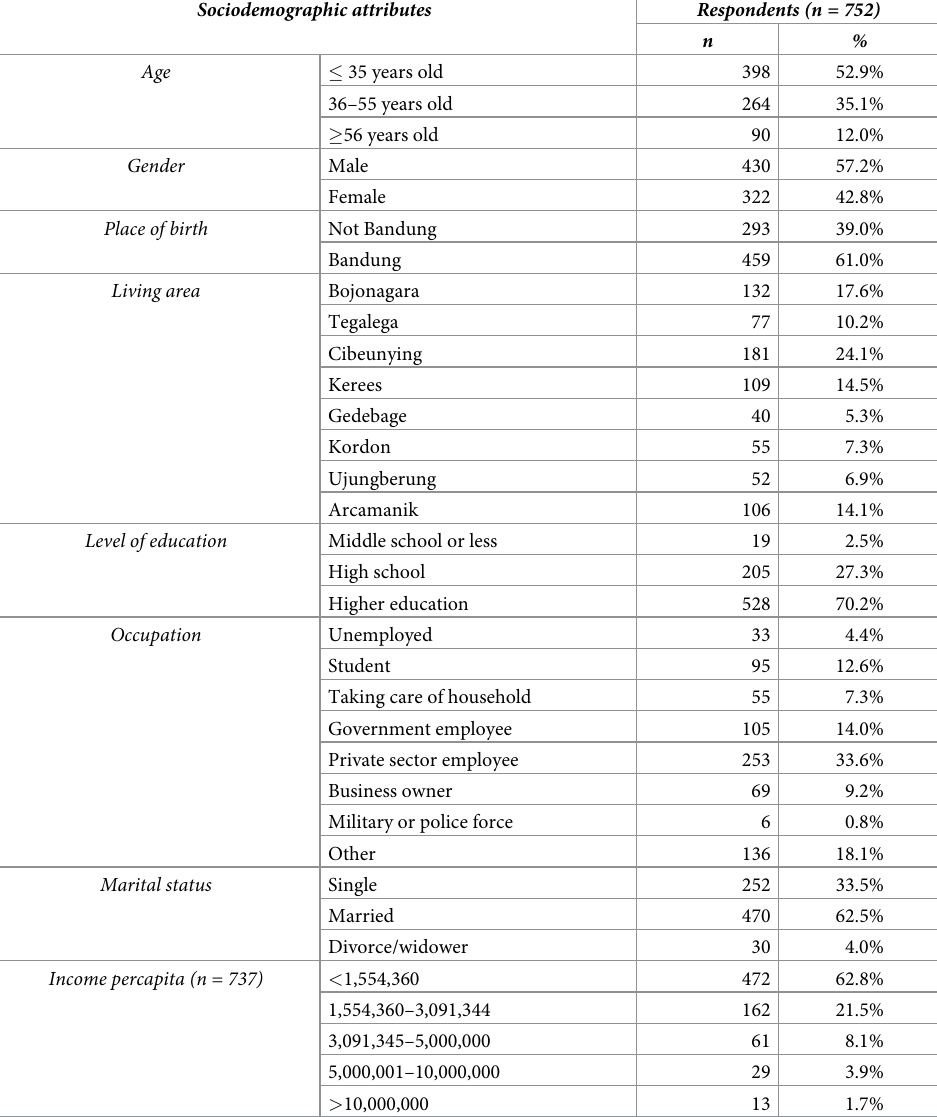
Table 1. Sociodemographic attributes of the respondents. Sociodemographic attributes